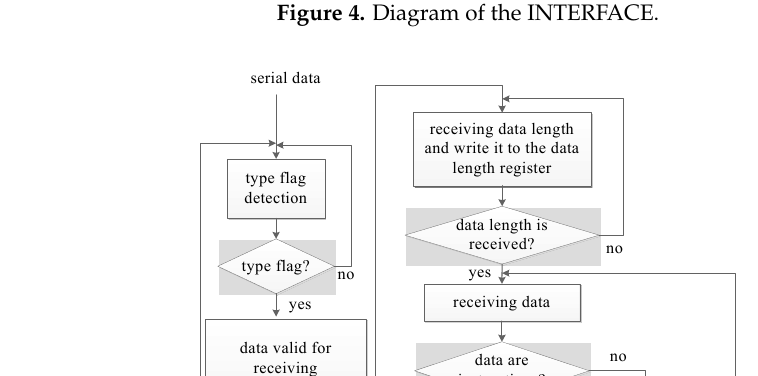
Appl. Sci. 2018 , 8 , 35